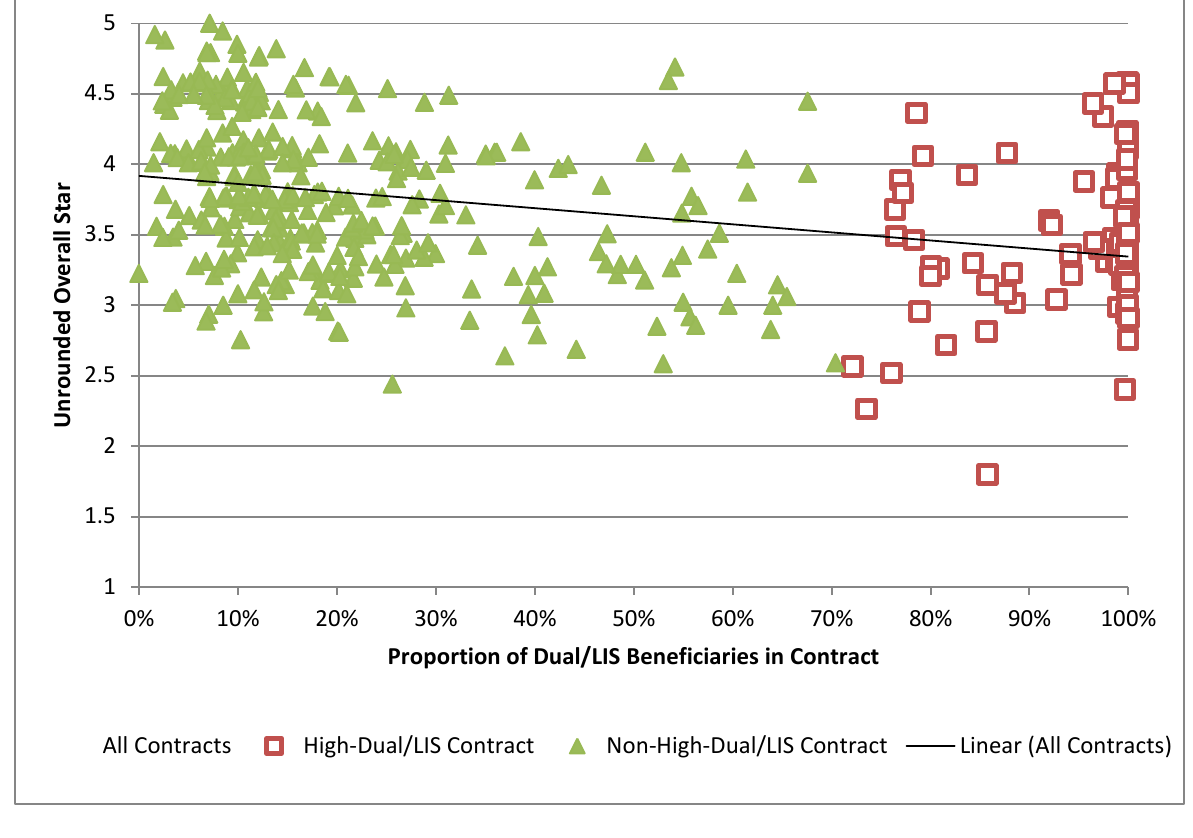
Figure 8.2: Relationship Between Proportion Dual/LIS and Quality Star